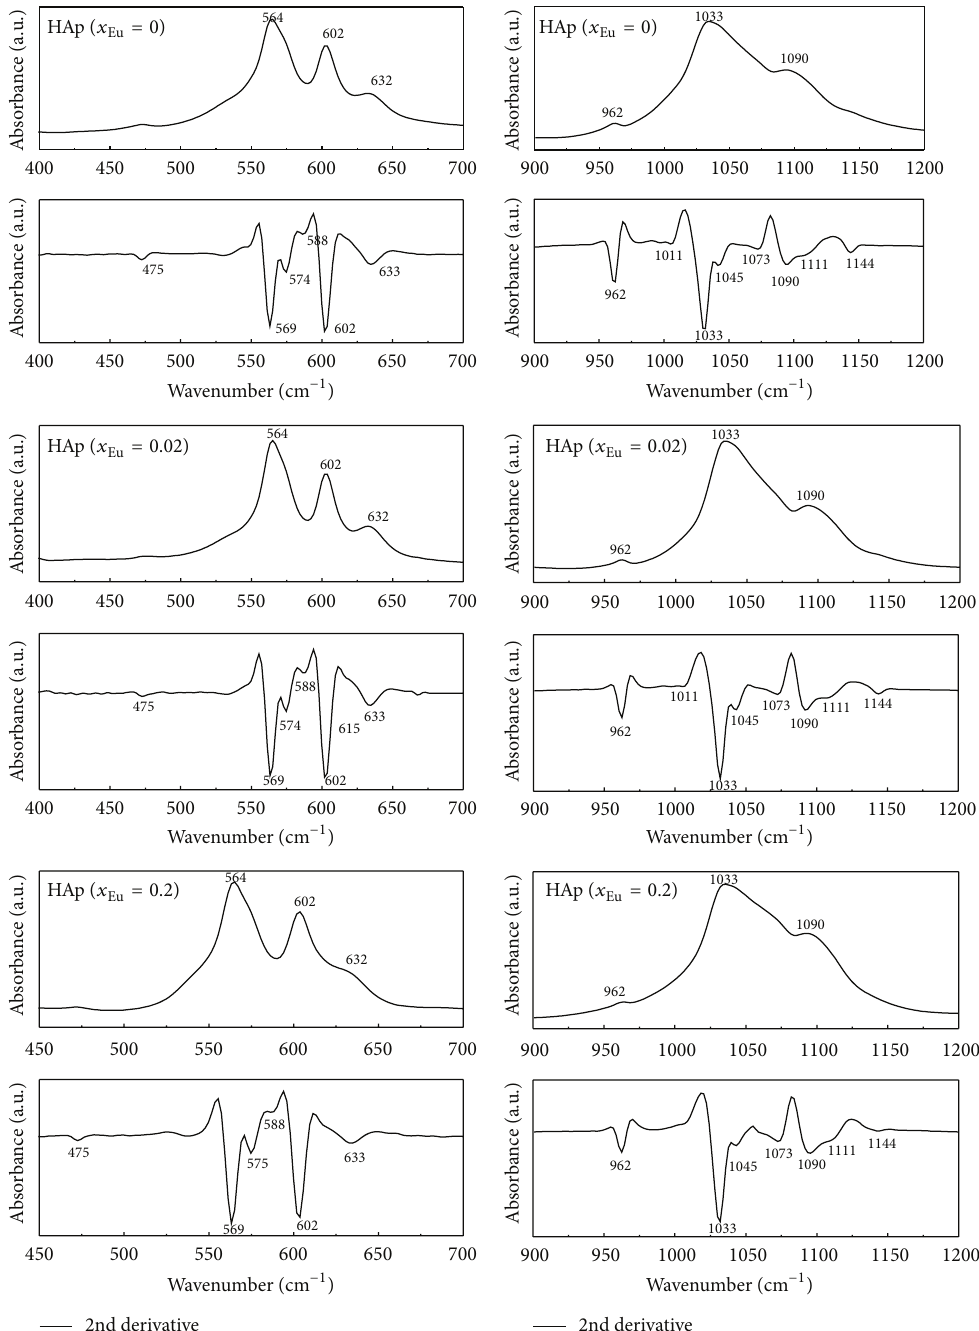
= 0.2 ) spectrum of the ] Eu